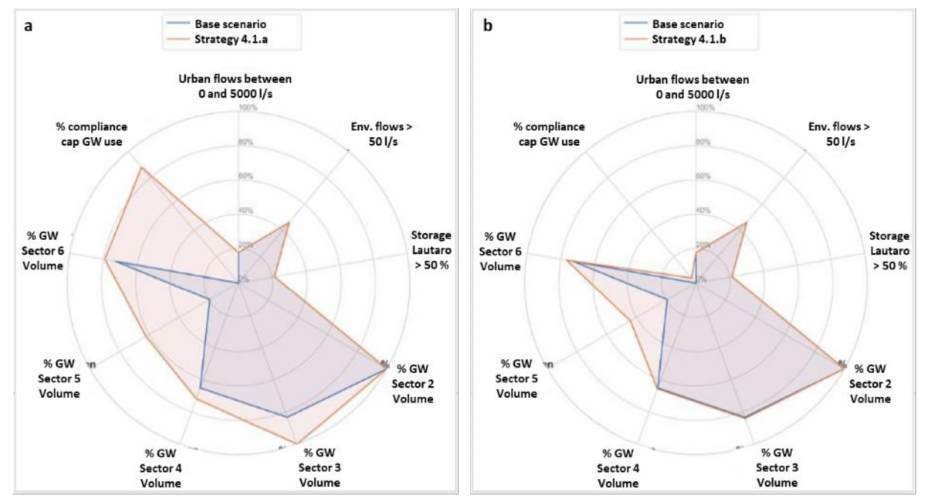
Figure 11. Impact indicators for strategy 4.1 (cap on groundwater use implemented through ABM) for two enforcement strategies: ( a ) high level of monitoring (90% of groundwater users) and fines (90% of revenue if farmer caught breaching the cap) and ( b ) low level of monitoring (20% of groundwater users) and fines (20% revenue if farmer caught breaching the